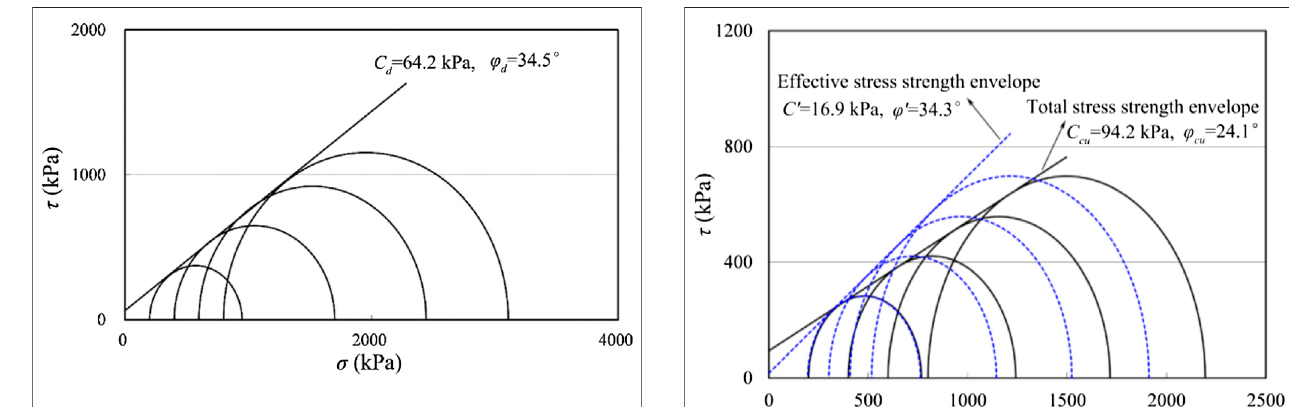
FIGURE 8 | Mohr circle and strength envelope of sericite quartz schist